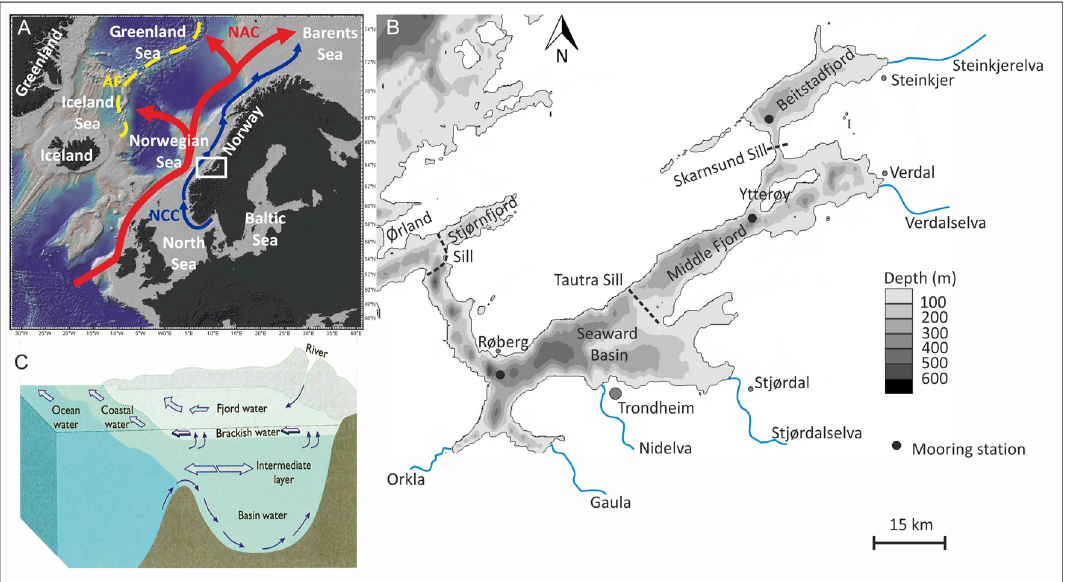
Fig. 1. (A) Surface circulation in the Norwegian Sea; (B) bathymetric map of the Trondheimsfjord. Black dots in the fjord indicate the location of the fixed mooring stations Røberg, Ytterøy and Beitstad referred to in the text; (C) main elements of the surface, intermediate and deep water circulation in Norwegian fjords (from Sætre, 2007).